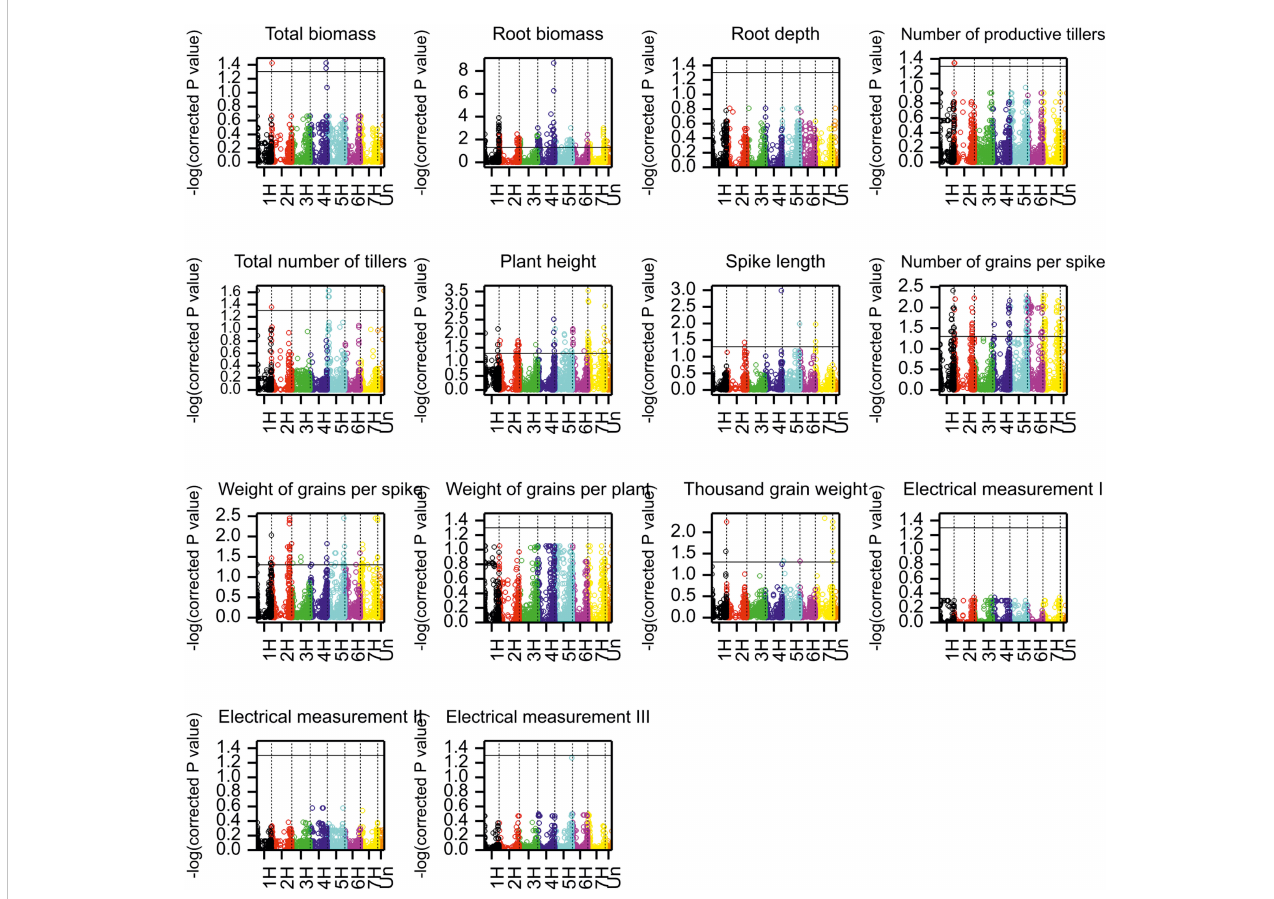
FIGURE 5 Manhattan plots for the associations of markers with phenotypic traits. Black horizontal line indicates − log(0.05), the signi fi cance threshold for log- transformed Benjamini-Hochberg corrected P values.